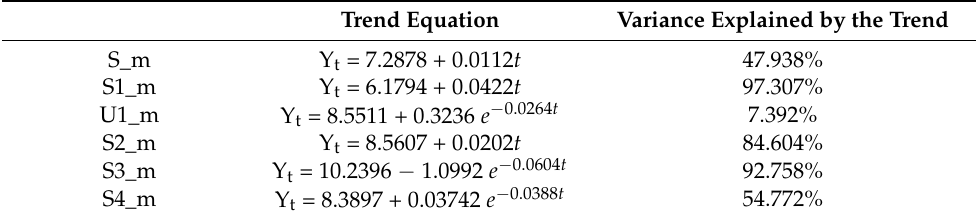
Table 6. The equations of the trend for the monthly series and subseries.